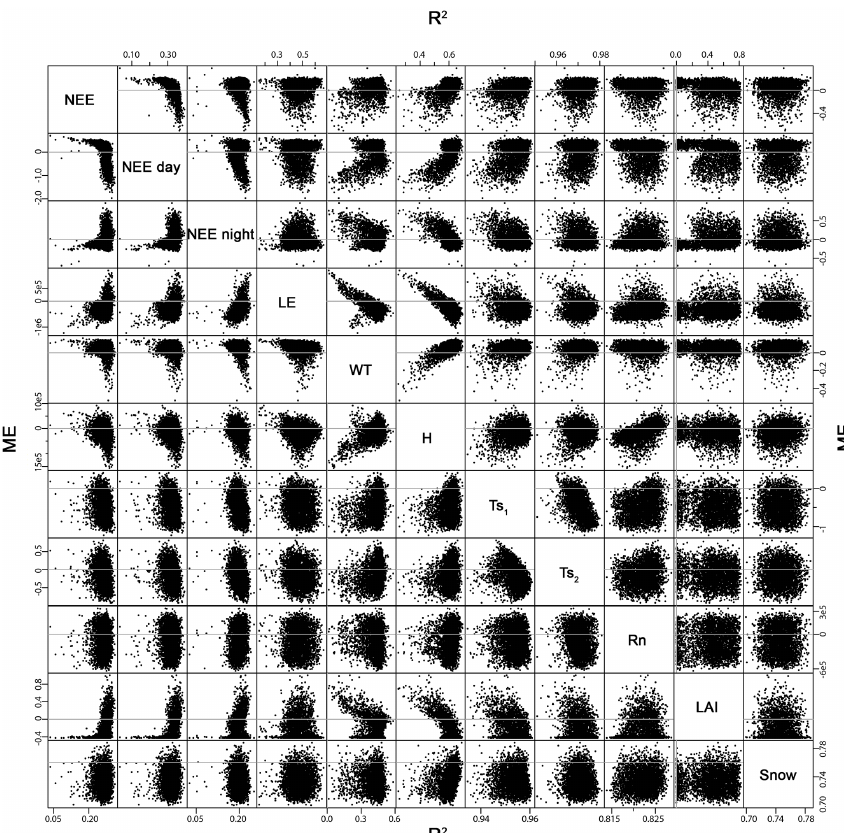
Figure 6. Correlations between performance indices in the prior distribution (3200 random runs): R 2 (columns) vs. mean error (ME) (rows). Each of the dots represents a parameter set. Grey lines indicate the axes through zero.